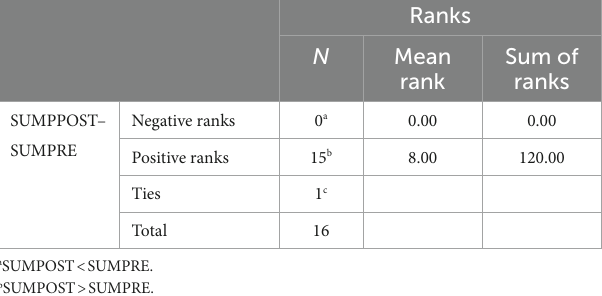
TABLE 8 Positive, negative, and tied paired differences of PST self- efficacy scores for scaffolded